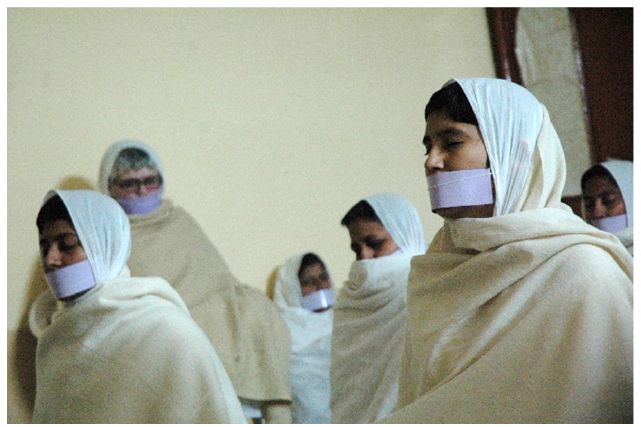
Figure 1. Ter ā panth ī sama ṇ ī s wearing the muhpatt ī during an evening pratikrama ṇ a ceremony. Lad- Figure 1. Ter¯apanth¯ı saman. ¯ıs wearing the muhpatt¯ı during an evening pratikraman. a ceremony. Ladnun, nun, December 2015. Photo by the author. December 2015. Photo by the